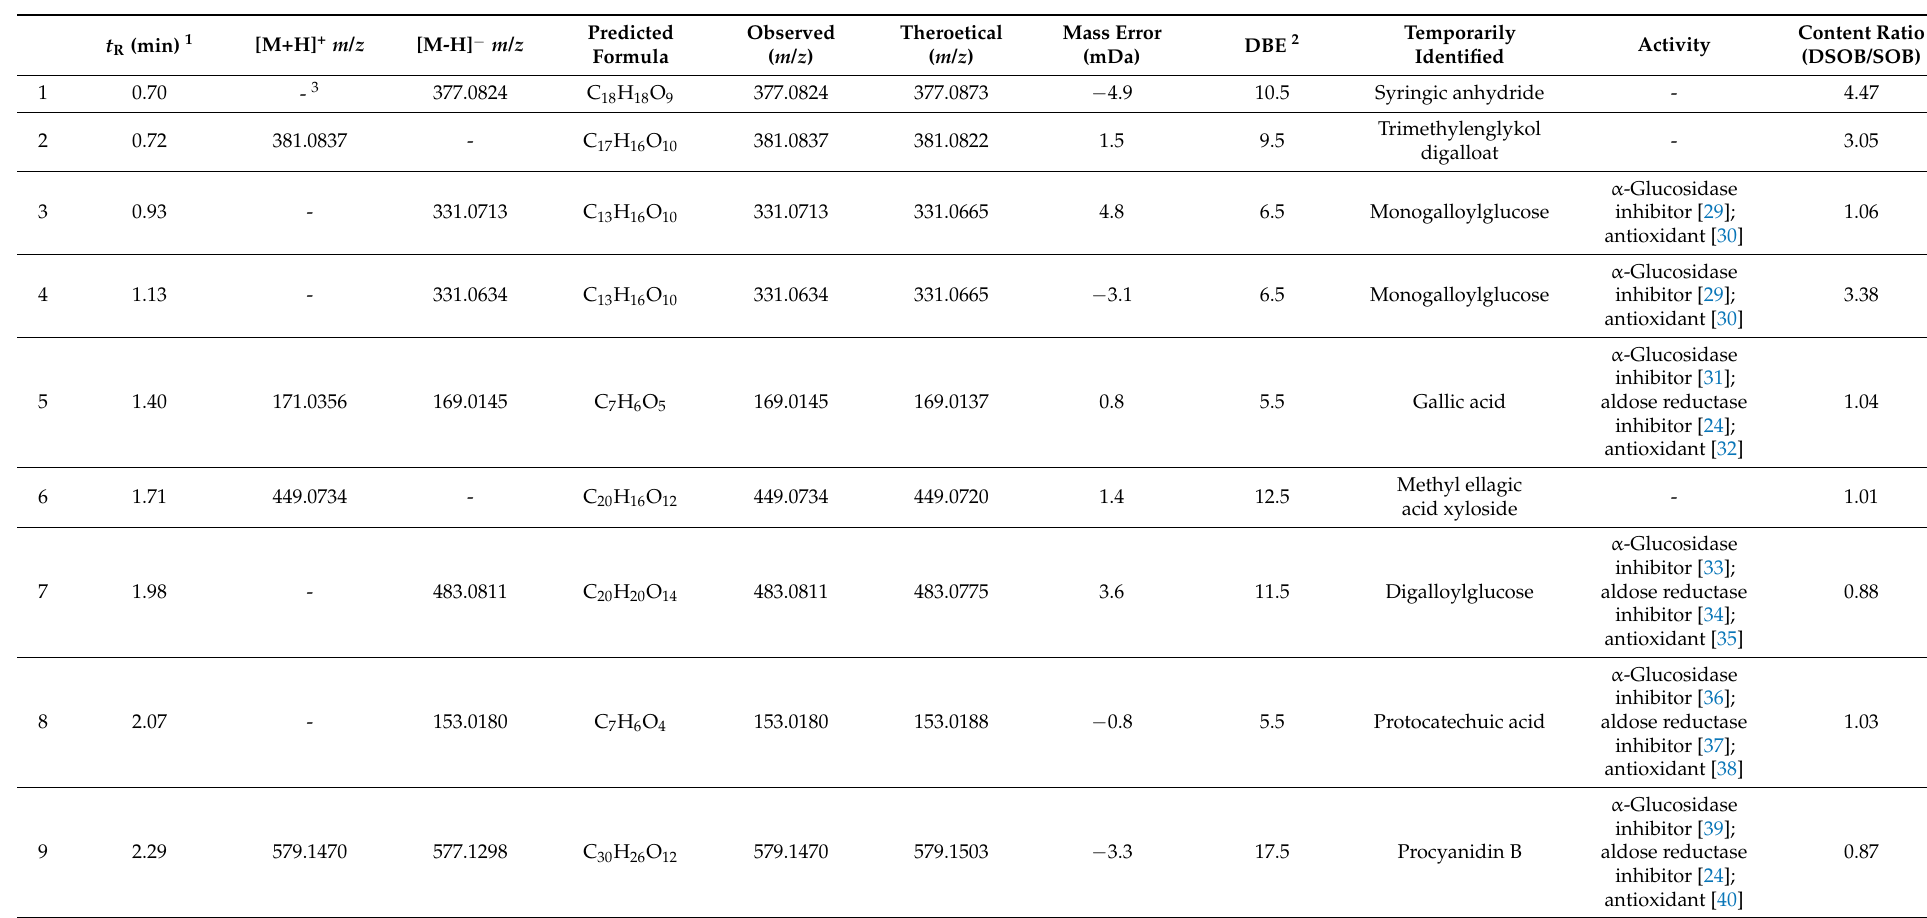
Table 4. Polyphenol compounds detected and tentatively characterized in defatted seeds of Oenothera biennis (DSOB) and seeds of Oenothera biennis (SOB) using liquid chromatography coupled with electrospray ionization and quadrupole time of flight mass spectrometry (LC–ESI–QTOF/MS) in positive and negative ion